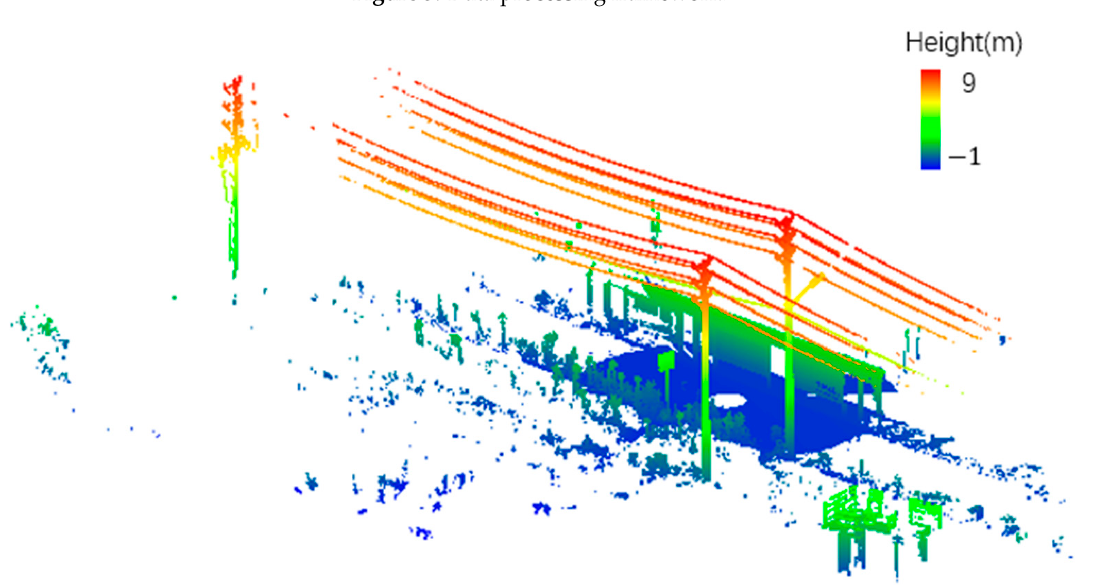
Figure 4. The data cropped from original terrestrial laser scanning (TLS) data. Ground filtering and height filtering are important prerequisites to reduce un- wanted objects. The point cloud data not only include powerlines but also a large number of outliers that are lower than powerlines (ground, shrubs, low buildings, etc.), which will hinder the extraction of the powerline point cloud. The cloth simulation filter is an efficient ground filtering method that utilizes the nature of cloth and modifies the phys- ical process of cloth simulation to adapt to point cloud filtering [31]. For disconnecting the powerlines from the ground, the ground is detected and removed by cloth simulation filter in this study. However, ground–filtered data may still include some unwanted ob- jects that are lower than the powerlines. The height filtering method that is based on the DTM (Digital Terrain Model) derived from the detected ground can further reduce the outliers and isolate the powerlines [7,8]. Thus, we also performed height filtering based on DTM. The DTM derived from the detected ground was raised to a certain height ( (cid:1860) (cid:3040)(cid:3036)(cid:3041) ), and points that were lower than the raised ground were removed. According to the National Electrical Safety Code (NESC), the vertical clearance of the lowest–level powerline is standardized as 6.4 m in China [11]. Considering the sagging factor, (cid:1860) (cid:3040)(cid:3036)(cid:3041) is set at a value of 5 m, which is lower than the NESC standard to ensure we did not miss any powerline points. As shown in Figure 5a, points that are 5 m above the ground are further extracted as off–ground points, while others are filtered out as outliers, and the filtered data are 90% less than before with total of 134,463 points The ground–filtered point cloud is of great redundancy with numerous points, which will influence the efficiency of processing. Thereby, data thinning is essential to accelerate the further processing. A voxel filter was used to streamline the ground– filtered point cloud; point cloud data were put into 3D voxels, and each voxel was 8 cm 3 in size; then, points within the same voxel are replaced by the centroid of them. As a re- sult, the voxel–filtered points are reduced by 90% compared to the original data, with a total of 1,350,728 points left. However, the original structure of the test point cloud data remains without losing any accuracy. Since the proposed method is carried out along the powerline, it is necessary to ro- tate the point cloud until powerlines are parallel to the X –axis. Powerlines are parallel to each other in XOY plane; thus, calculating the angle of one of the powerlines is enough for rotation. First, we selected line1 on the XOY plane and converted the coordinate origin to one end of line1, as shown in Figure 5b; (cid:1868) (cid:3036) ( (cid:2025) (cid:3036) , (cid:2016) (cid:3036) ) represents 2D points on the line1 ( i = 1 − n, n is number of points). When line1 is parallel to the X–axis, (cid:2016) (cid:3036) and the rotation angle (cid:2016) should satisfy the following conditions: